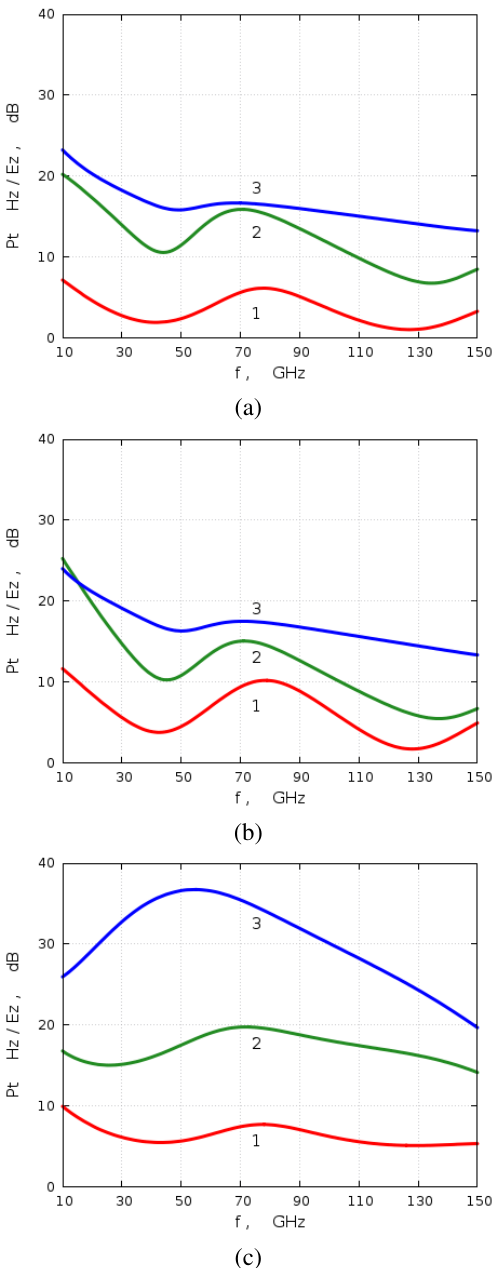
Figure 6: Polarization ratio for the waves reflected from (a) strip-like ( P L = 0 . 1 , 1 , 10 kW/cm 2 ), (b) wire-like ( P L = 1 , 10 , 100 kW/cm 2 ), and (c) fin-like ( P L = 0 . 1 , 0 . 3 , 1 kW/cm 2 ) photo-excited gratings (curves 1 to 3,